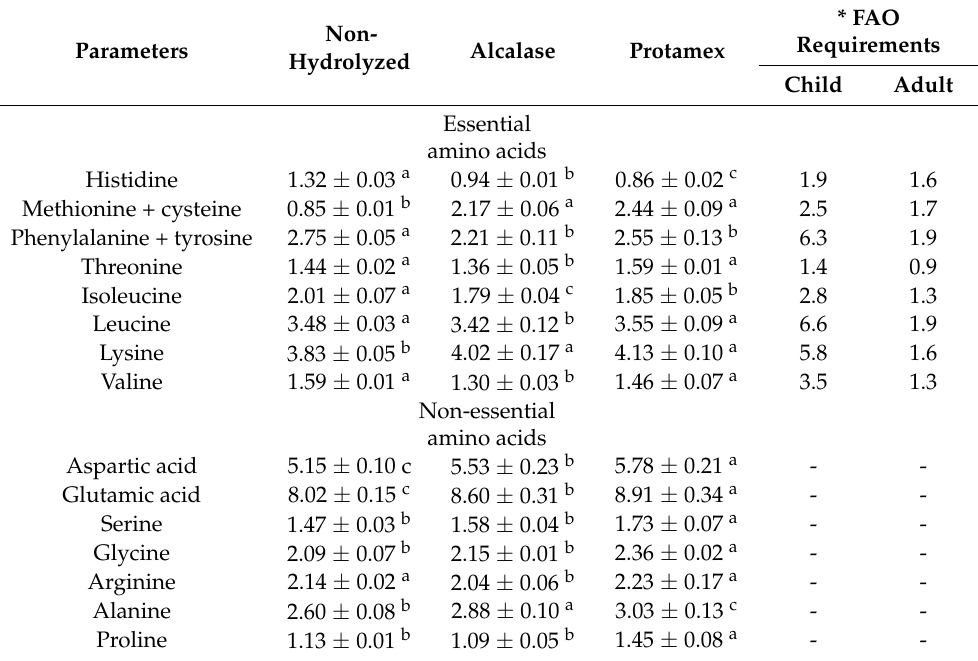
Table 3. Amino acid composition (g/100 g sample) of non-hydrolyzed soybean protein and protein hydrolysates (dry weight basis) in children vs.